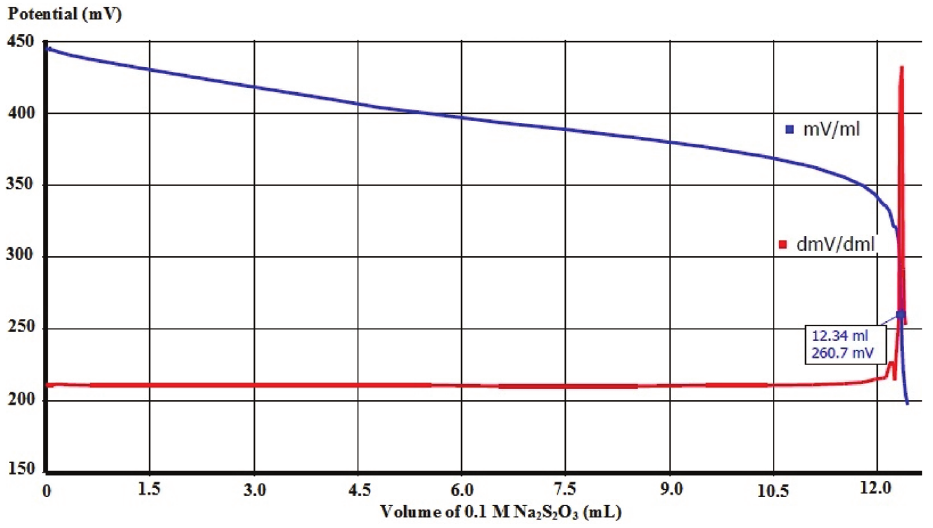
Fig. 3: Titration plot of potential versus titrant